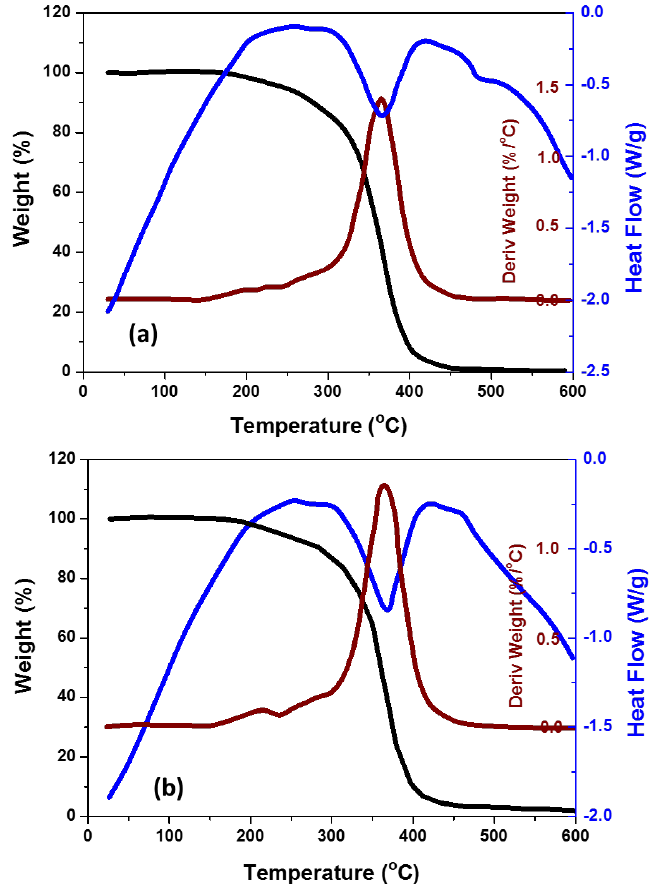
Figure 3. Differential scanning calorimetry and thermogravimetric analysis of ( a ) pure PMMA and ( b ) PMMA/2 wt. % TiO 2 .